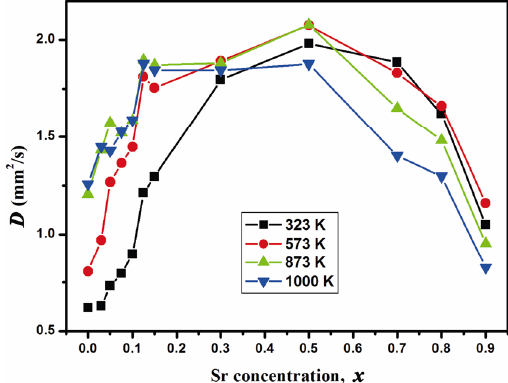
Fig. 9 Power factor (PF) for La 1– x Sr x CoO 3 with 0 ≤ x ≤ 1 at 330 K.